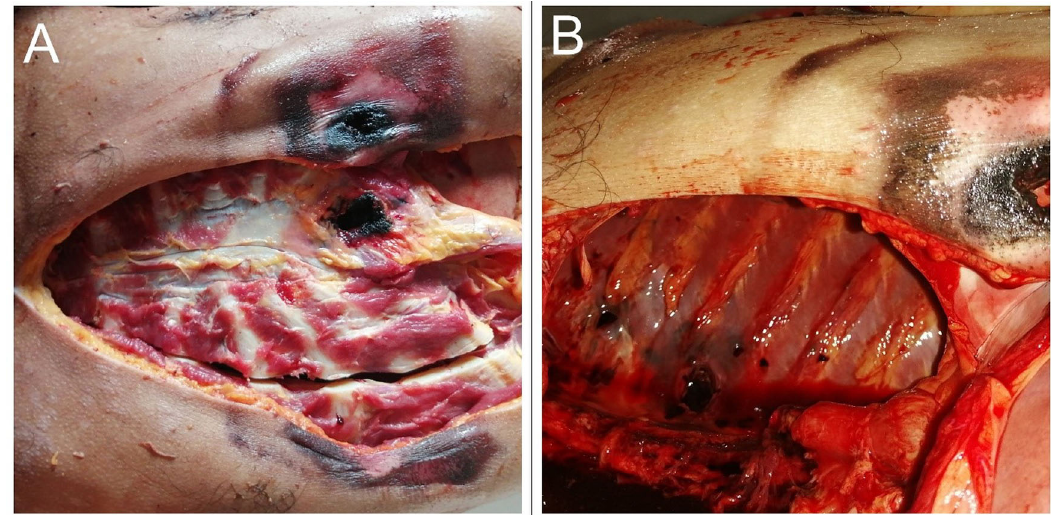
Figure 2. A, A perforating fracture in the xiphoid process. B, Punctured laceration is seen in the posterior chest wall.